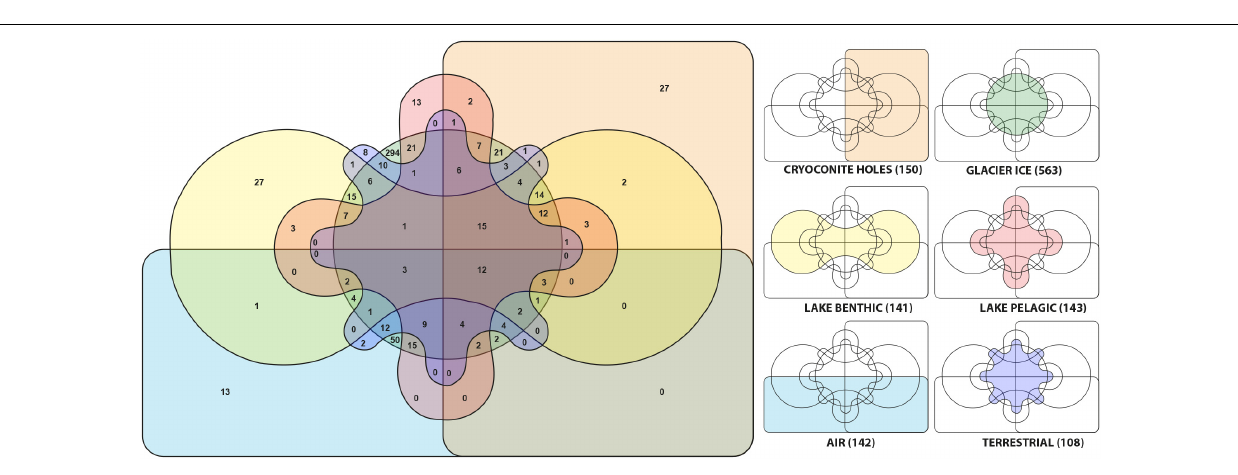
Fewer cyanobacterial affiliated RSVs were detected in the samples “LAKE PELAGIC” (3.4%), TERRESTRIAL (2.6%) and “AIR”